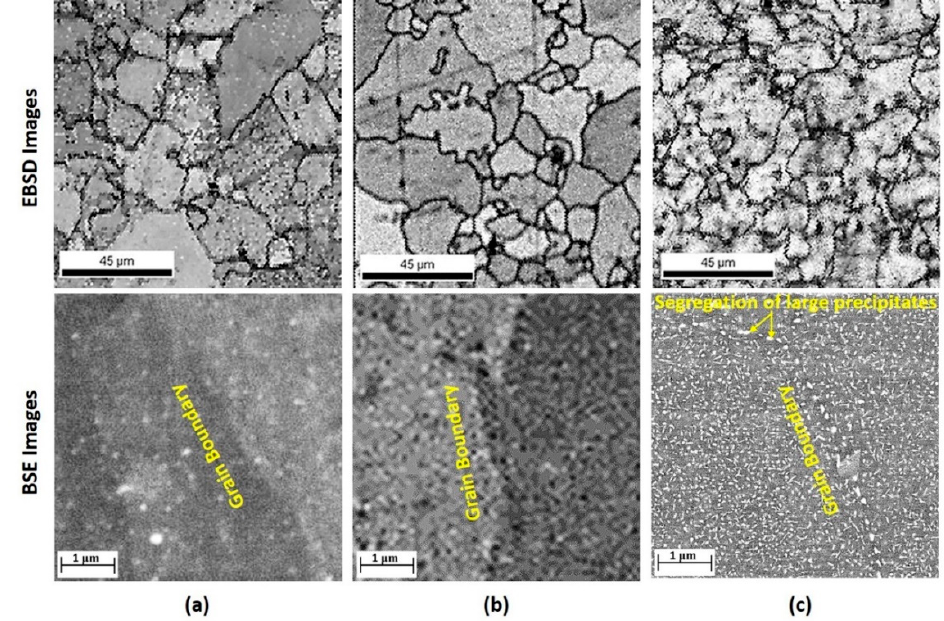
Figure 2. Electron backscatter diffraction (EBSD) micrographs (image quality maps) and corresponding BSE images of AA7075; ( a ) as-received, ( b ) processed in a die with temperature of 24 °C, and ( c ) processed in a die with temperature of 350 °C.